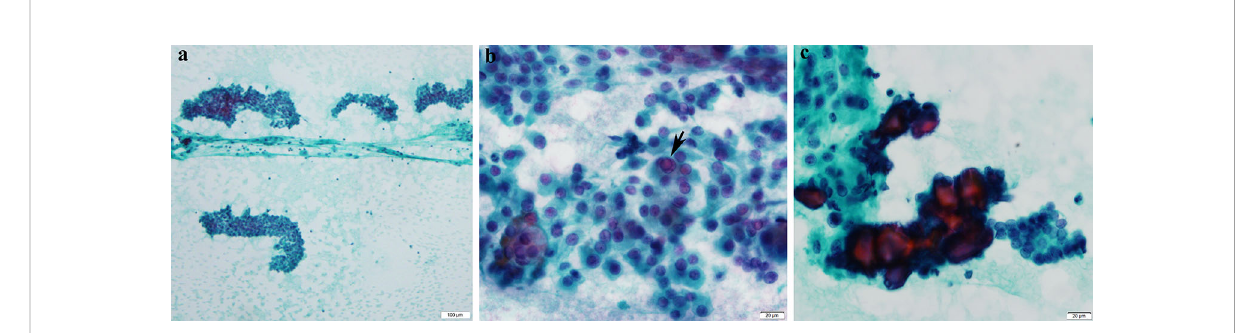
FIGURE 3 Cytological features of papillary thyroid carcinoma. (A) Cellular smears with loose cohesive clusters of malignant cells (Pap*, ×100). (B) The malignant cells display enlarged overlapping nuclei with irregular contours and fi ne powdery chromatin. Occasional intranuclear inclusions (arrow) and grooves are observed (Pap, ×600). (c) Psammoma bodies are also noted (Pap, ×600). *Papanicolaou